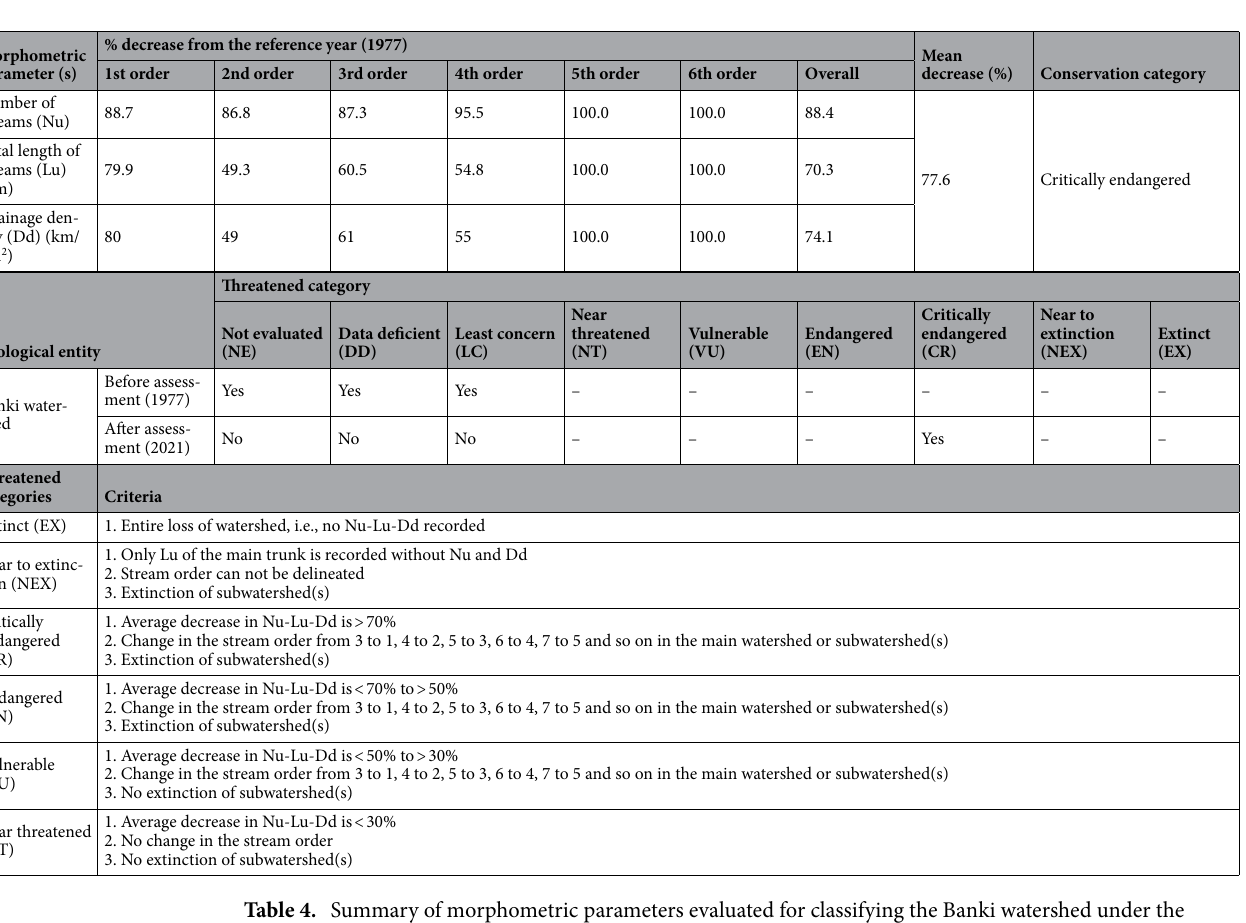
Table 4. Summary of morphometric parameters evaluated for classifying the Banki watershed under the proposed